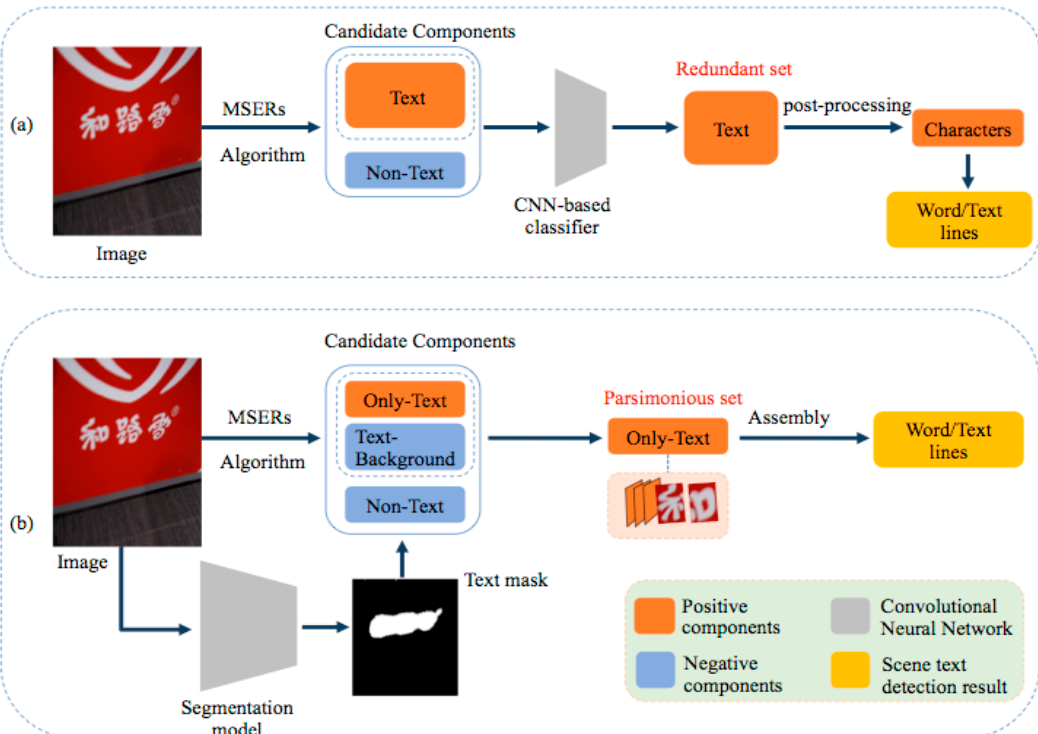
Figure 2. Comparison of the pipelines of the previous works and the proposed approach. The top row ( a ) is a common workflow of previous component-based methods. The bottom row ( b ) is the proposed framework.